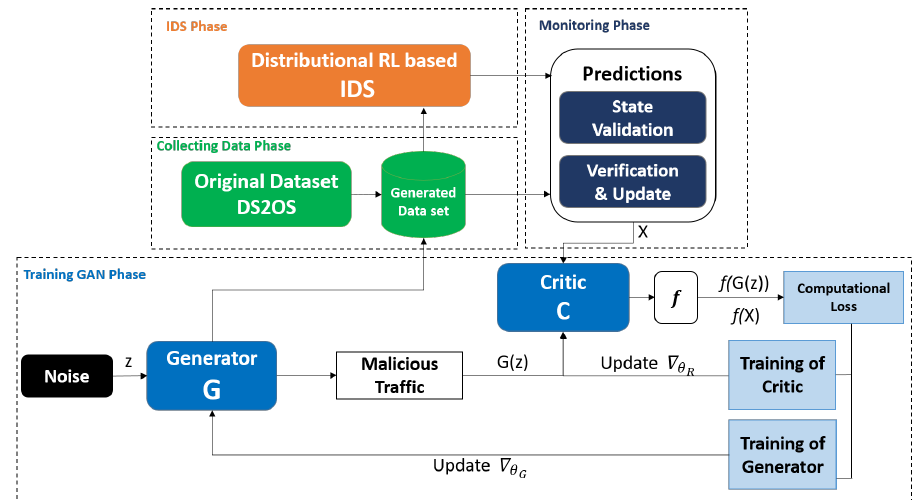
Figure 1. Process flow of anomaly detection based on